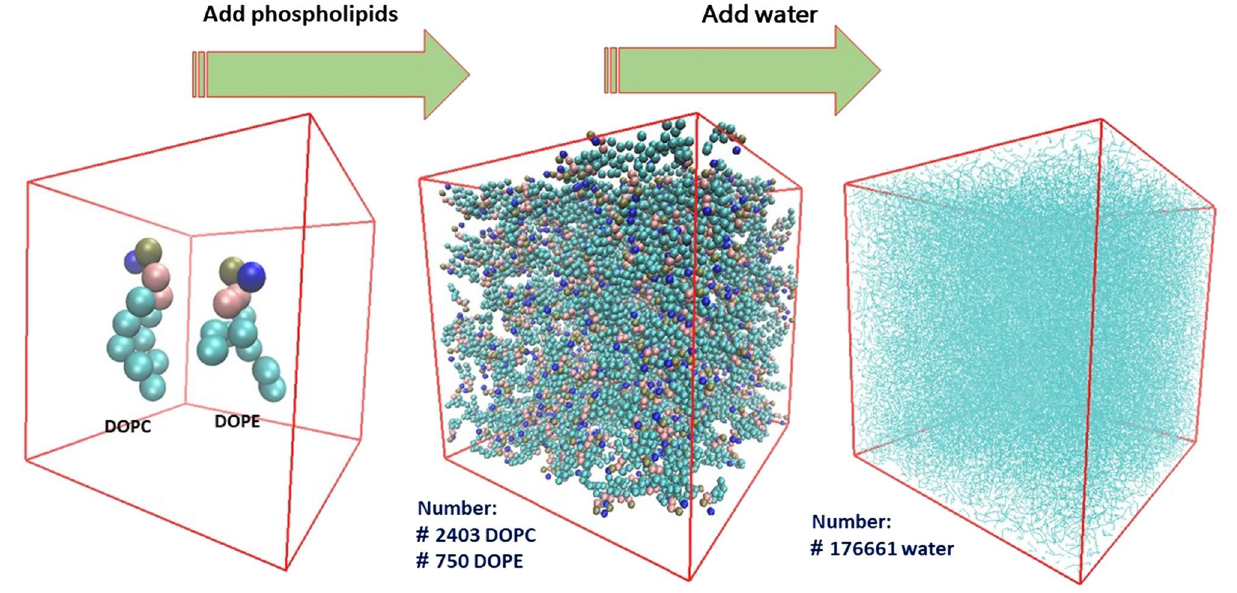
Figure 3. Schematic of simulation box and add phospholipid and water molecules inside the box. The box was made to cubes form and the molecules are homogeneously being distributed throughout the